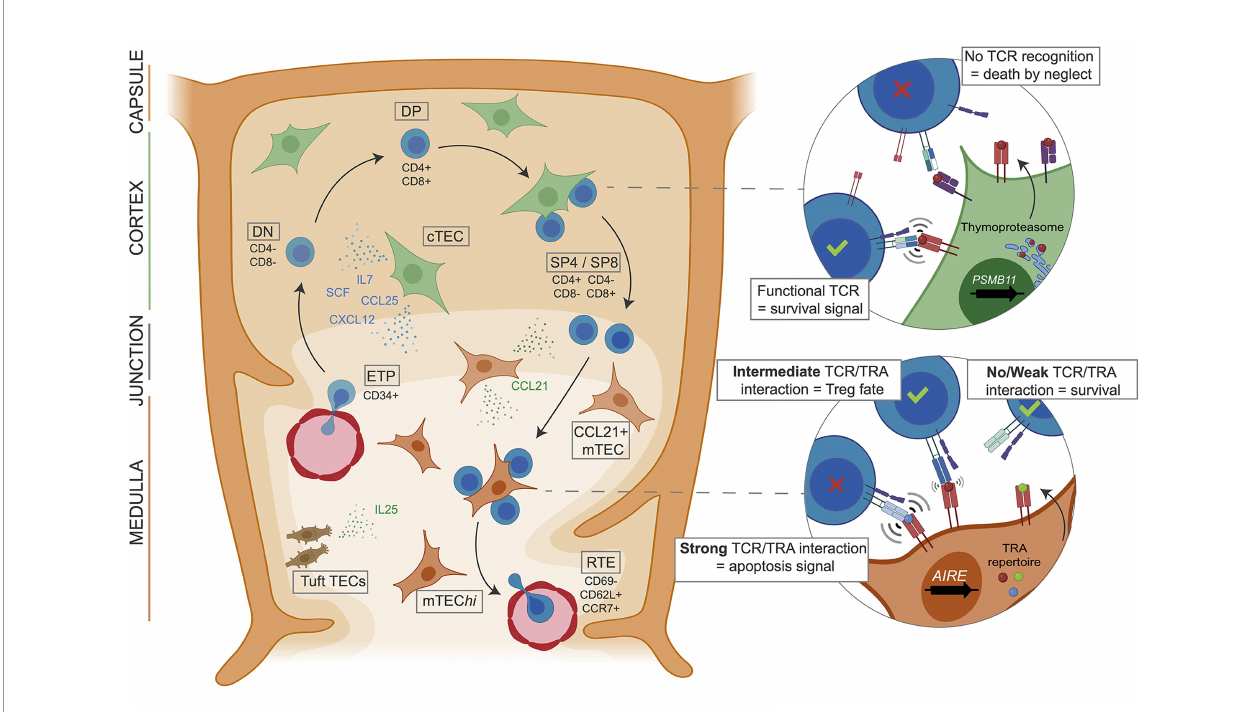
FIGURE 1 | cTEC and mTEC orchestrate thymocyte maturation and selection. Early thymic progenitors (ETP) originating from the bone marrow enter the thymus and are attracted to the cortical region by chimiokines expressed by cTECs, also inducing growth and T lineage commitment by contact with NOTCH ligands. After TCR rearrangement CD4/CD8 DP thymocytes enter positive selection of the functional TCRs mediated by cTEC expressing the thymoproteasome. Resulting SP T cells are attracted to the medulla where thymocytes with auto-reactive TCRs are negatively selected by mature mTECs presenting the self-antigen repertoire under AIRE regulation. Thus, T cells with functional TCRs, able to recognize foreign antigens but tolerant to the self, are generated by the